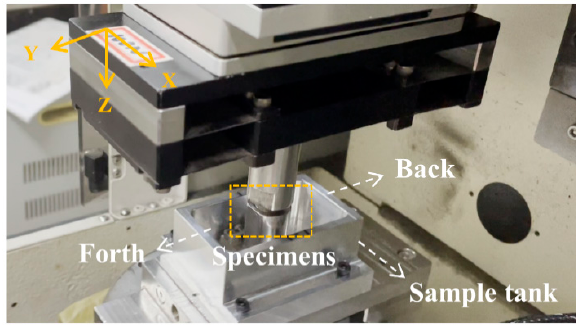
Figure 3. Schematic of friction wear process.